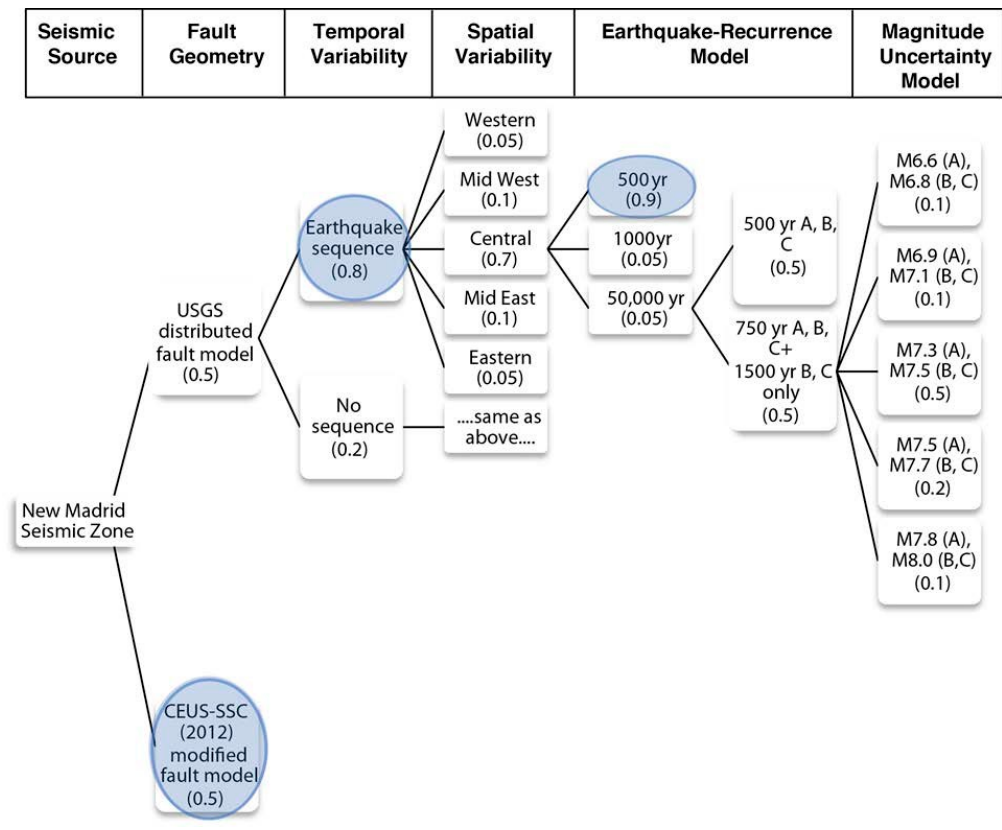
Figure 33. Logic tree of NMSZ seismic source model in US National Probabilistic Seismic Hazard Maps (modified from Reference [34]). Paleoliquefaction data are reflected in increased weighting of earthquake sequence and 500-year recurrence time compared with the earlier model.